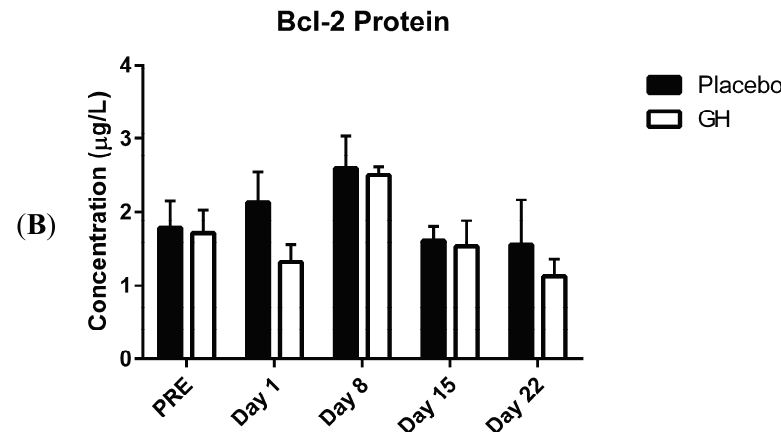
Figure 1. ( A ) Protein concentrations of Bak from peripheral blood mononuclear cell (PBMC) mitochondrial extracts in recombinant human growth hormone (rhGH) treated compared to placebo treated samples; ( B ) Protein concentrations of Bcl-2 from PBMC mitochondrial extracts in rhGH treated compared to placebo treated samples. ( * p < 0.05 compared to